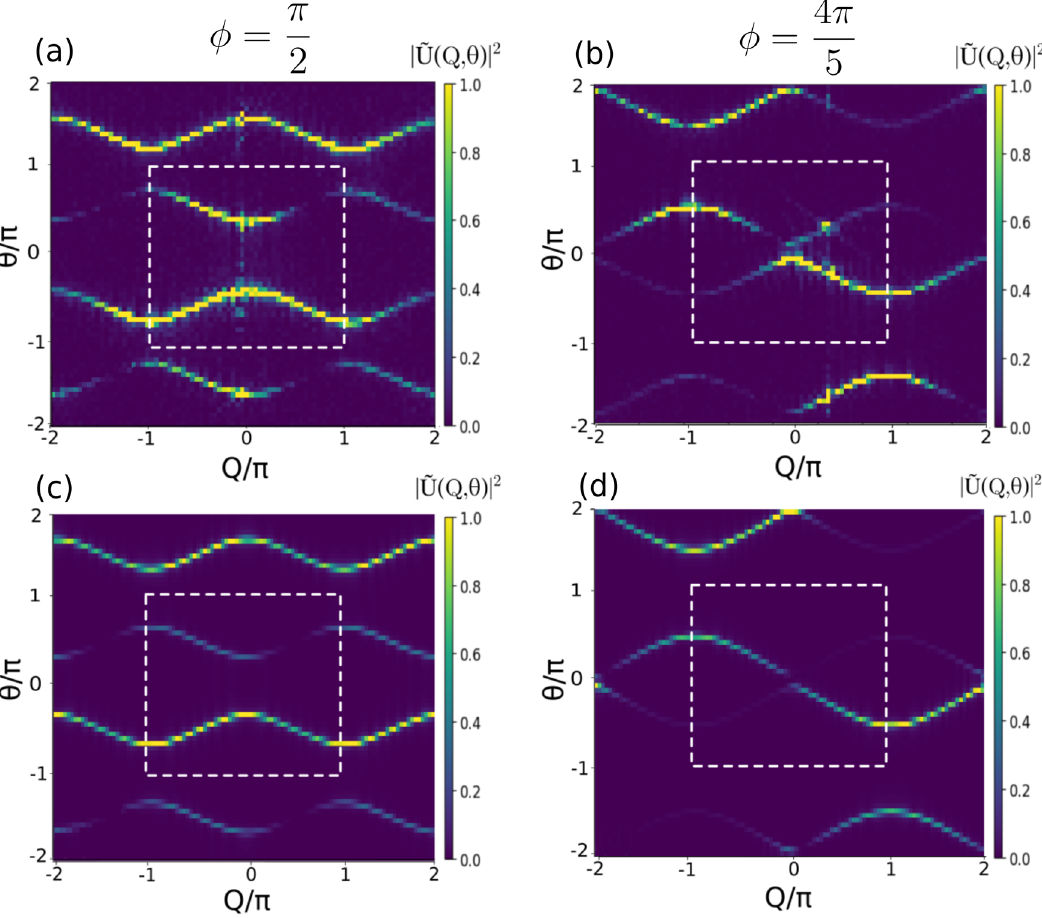
Fig. 3 Comparison between experimental and numerical results. a , b Experimental results showing the dispersive band structure of the photonic mesh lattice recorded with periodic square modulations of the phase with amplitudes ϕ 1 = π /2 ( a ) and ϕ 2 = 4 π /5 ( b ). c , d Corresponding numerical simulations showing the band structure computed from the 2D Fourier transform of the impulse response of the system. Numerical simulations are made using Eqs. (1) and (2) with Φ 1 ( m ) = ( − 1) m π /2 ( c ) and Φ 2 ( m ) = ( − 1) m 4 π /5 ( d ). The squares in white dashed lines represent the fi rst Brillouin zone. The vertical color bar indicates the mapping from the normalized spectral power j ~ U ð Q ; θ Þj 2 to